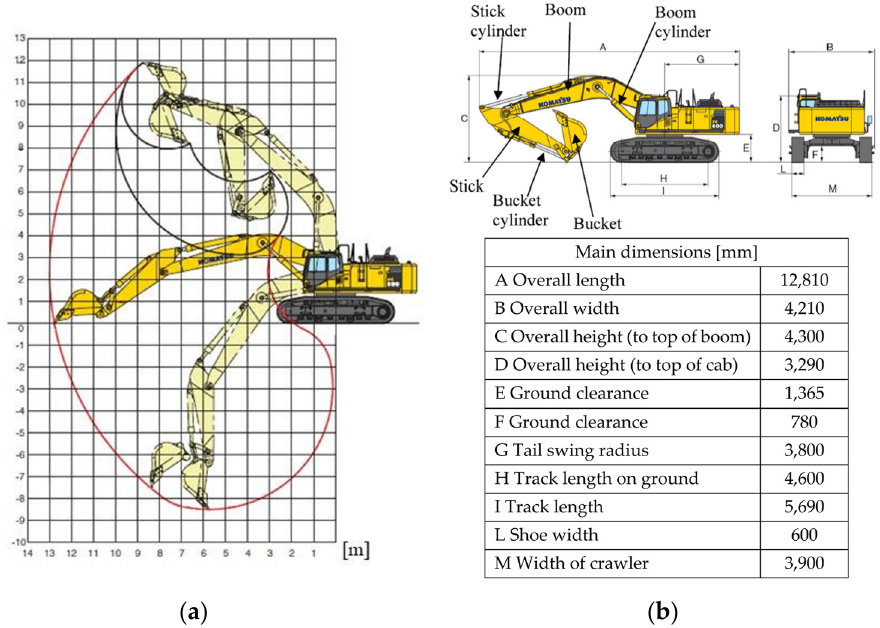
Figure 1. Excavator object of the study: ( a ) load diagram; ( b ) main